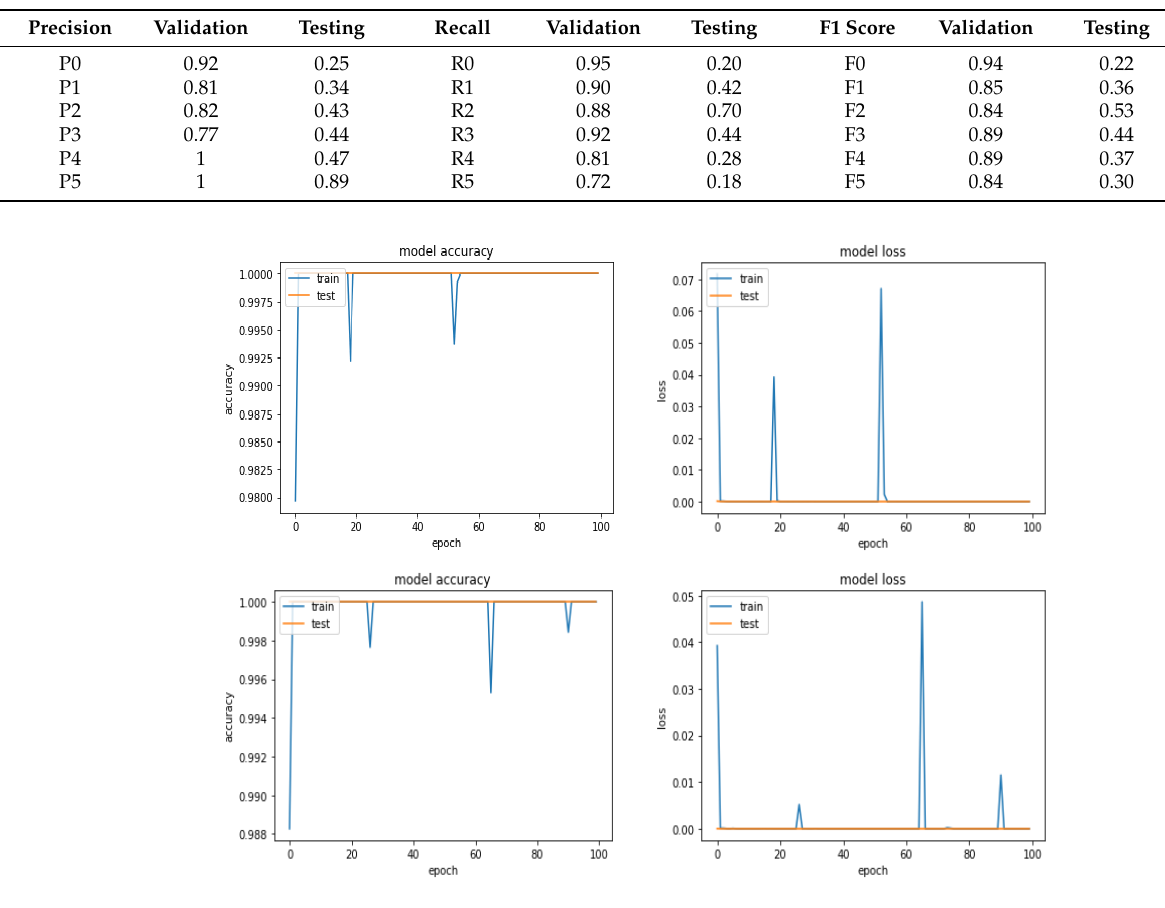
Figure 16. Accuracy and Loss for LSTM and VAE-CNN for two-class classification for training and validation phase respectively.